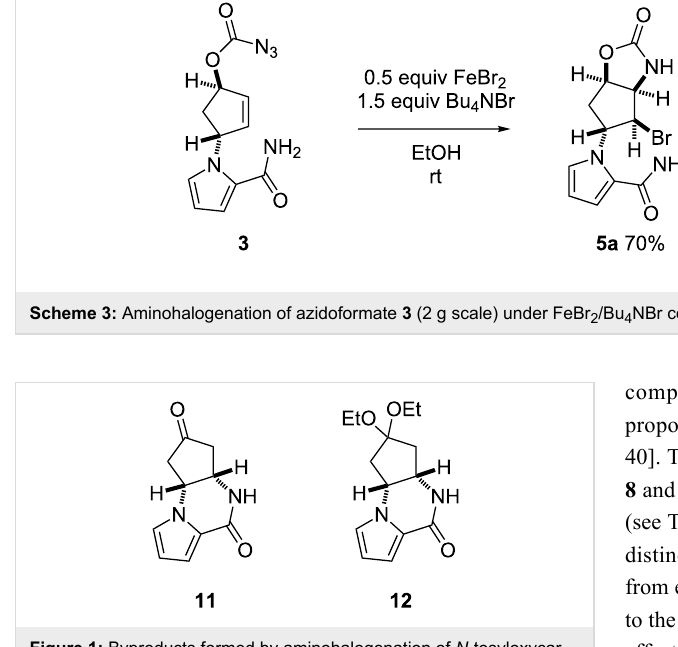
Figure 1: Byproducts formed by aminohalogenation of N -tosyloxycar- bamate 8 with FeCl 2 /TMSCl in EtOH (see Table 1; entry 7).